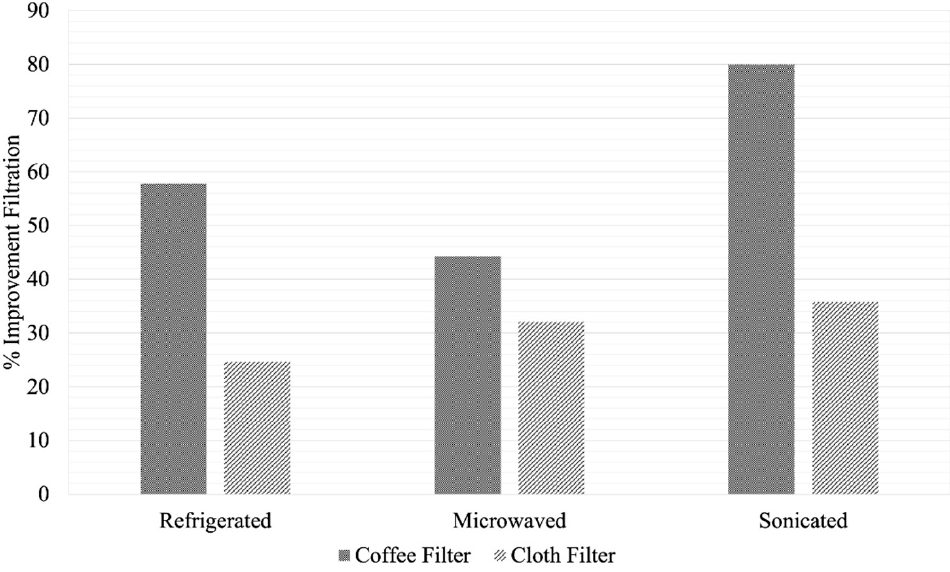
Figure 4. Percent improvement on filtration efficiency of the filter made under different treatment methods.